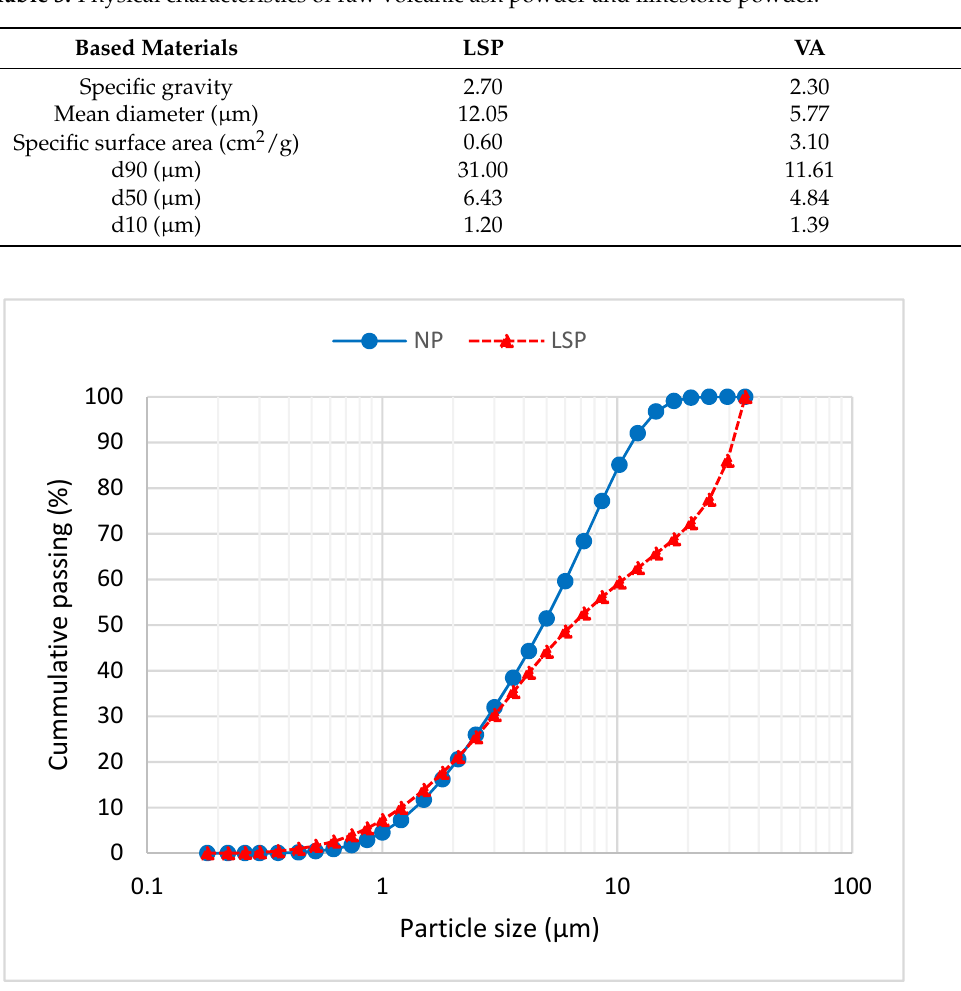
Table 3. Physical characteristics of raw volcanic ash powder and limestone powder .